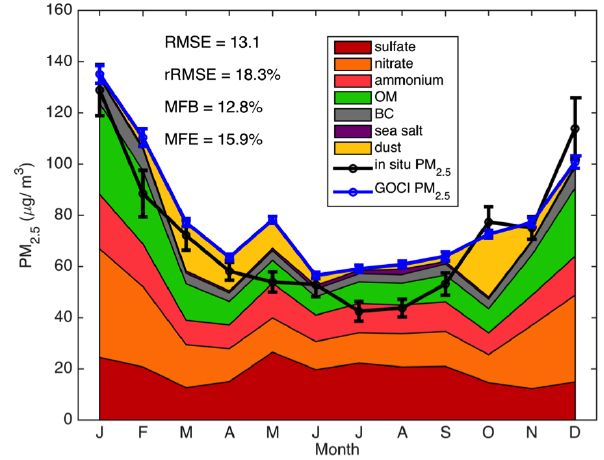
Figure 6. Monthly variation of GOCI-derived PM 2 . 5 and in situ PM 2 . 5 for 2013 over eastern China, with chemical composition for GOCI-derived PM 2 . 5 . The in situ PM 2 . 5 is determined from the av- erages of all ground stations in eastern China for 2013 and GOCI- derived PM 2 . 5 is calculated from the average of all grid boxes that contain PM 2 . 5 ground monitors. The chemical composition is cal- culated by applying the GEOS-Chem simulated mass fraction of PM 2 . 5 chemical components to GOCI-derived PM 2 . 5 mass concen- tration. Aerosol water is associated with each PM 2 . 5 component ac- cording to its hygroscopicity. Error bars represent standard